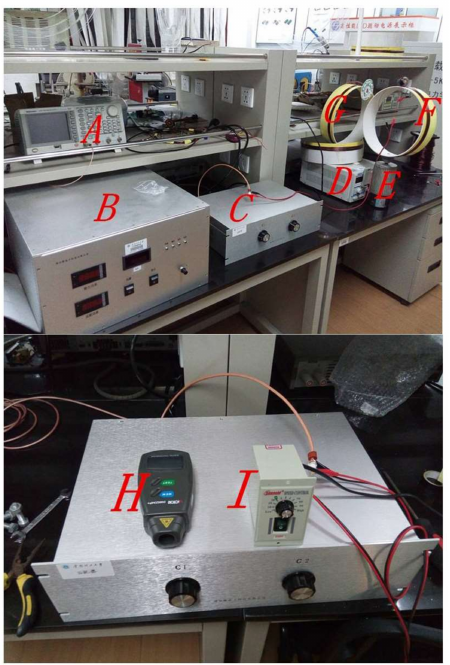
Figure 13. Experiment